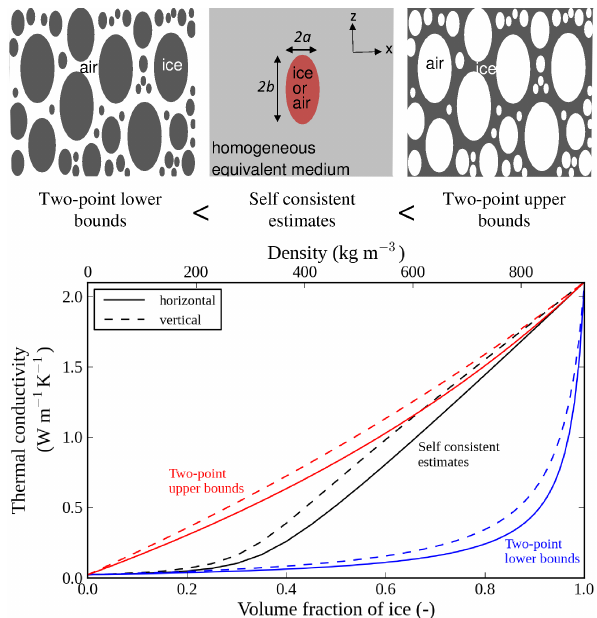
Figure 4. Schematic representation of the microstructure corre- sponding to the two-point bounds and the self-consistent scheme. Effective thermal conductivity versus ice volume fraction when b/a = 1.45: self-consistent estimates (black curves), two-point lower (blue curves) and upper (red curves)